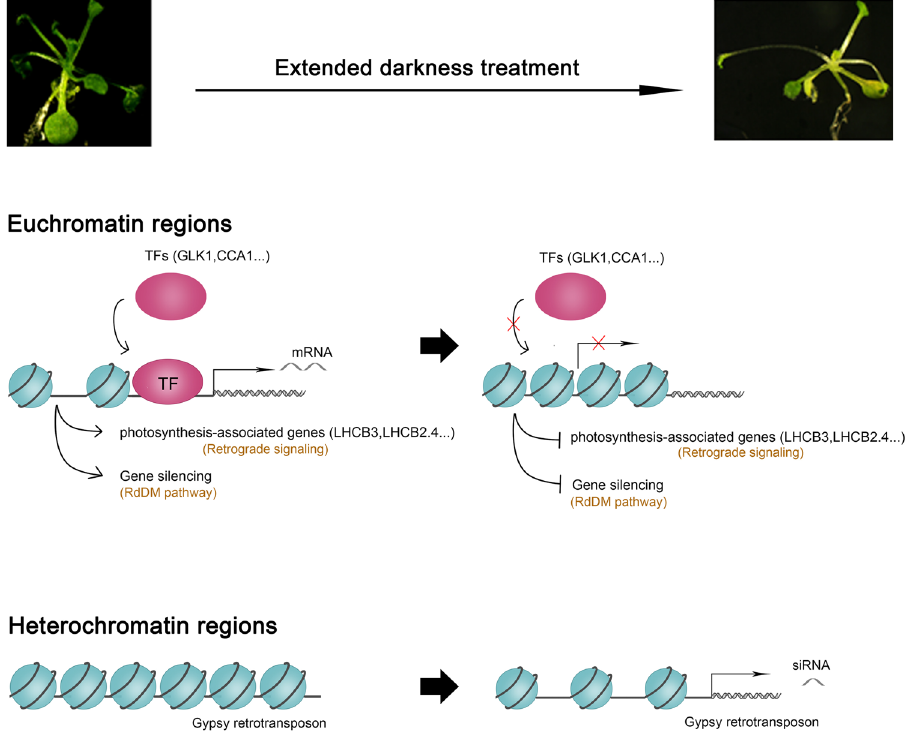
Figure 6. Model for changes in chromatin accessibility during extended darkness. In euchromatin, chromatin becomes closed during extended darkness. This change represses the binding of light-associated TFs, such as GLK1 and CCA1, to DHSs in the promoters of downstream photosynthesis-associated genes. The repression of photosynthesis-associated genes may be influenced by retrograde signaling. In addition, gene silencing, such as the RdDM pathway, is also repressed by closed chromatin. In heterochromatin, chromatis tends to open during extended darkness, and LTR/Gypsy transposons are transcribed into